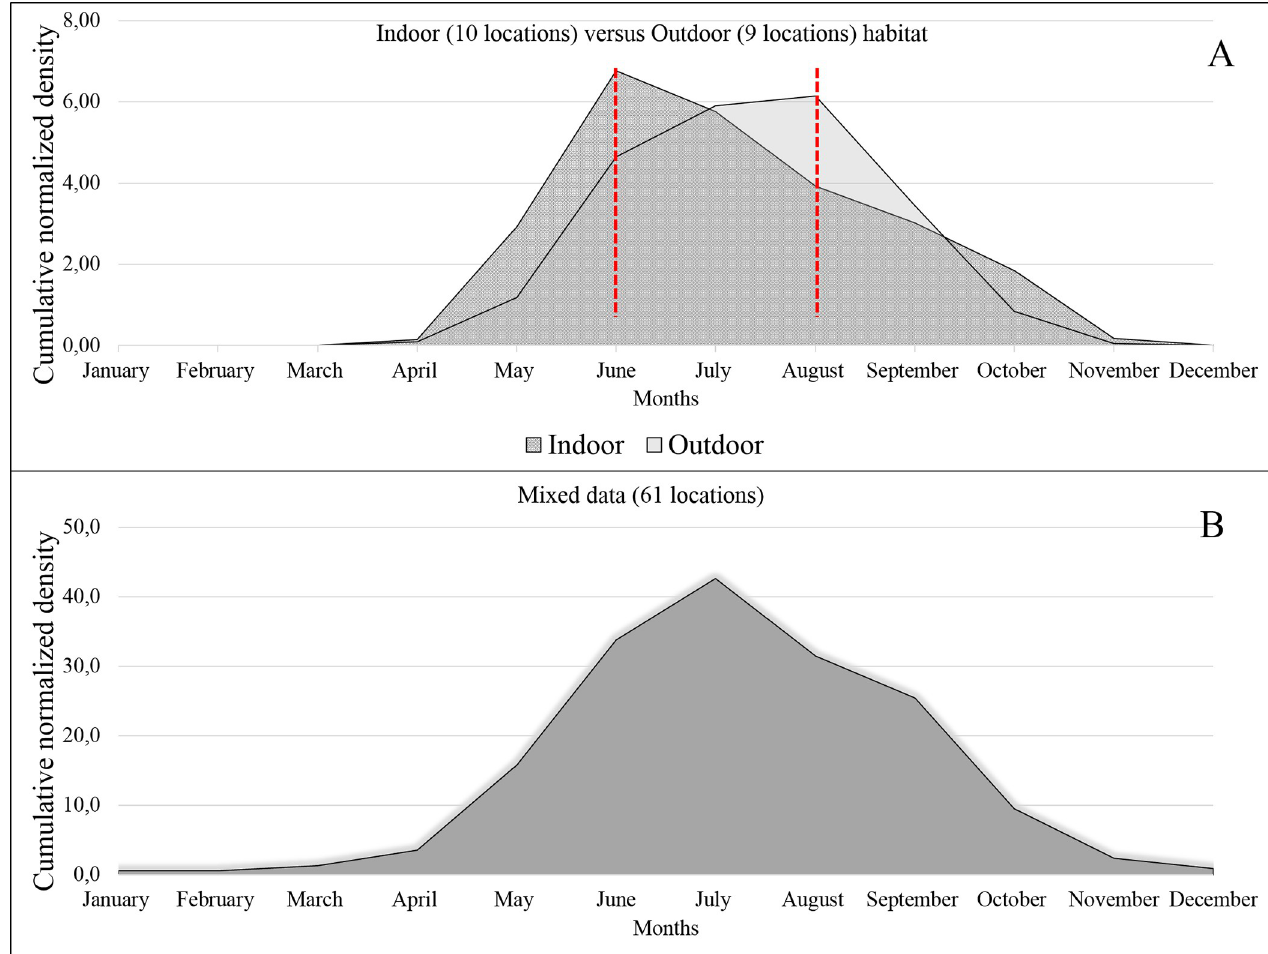
Fig 9. Cumulative normalized seasonal density of P . (Par . ) sergenti in the 12 countries included in the study. Normalized densities were pooled from the 63 locations in 12 countries collected in various habitats (indoor-outdoor) using a panel of trapping methods (Light, sticky, or CO2 traps, aspirator ... ) (A) Normalized densities were pooled from 10 locations in countries (Morocco, Pakistan, Iran, and Georgia) indoor habitat and 9 locations in 3 countries (Morocco, Pakistan, Iran) for outdoor habitat; (B) Mixed data (Indoor and outdoor) of the 63 locations.